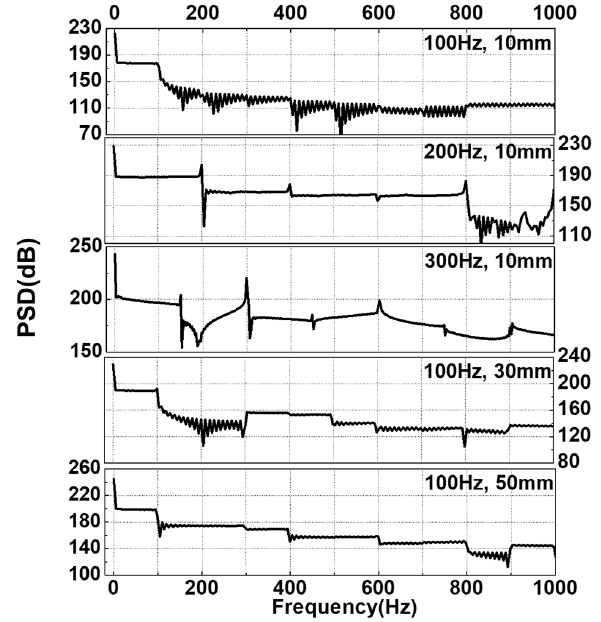
Figure 13. PSD of the axial compressive stress signal on the stress concentration node of the press- board in phase 3 under different vibration conditions.